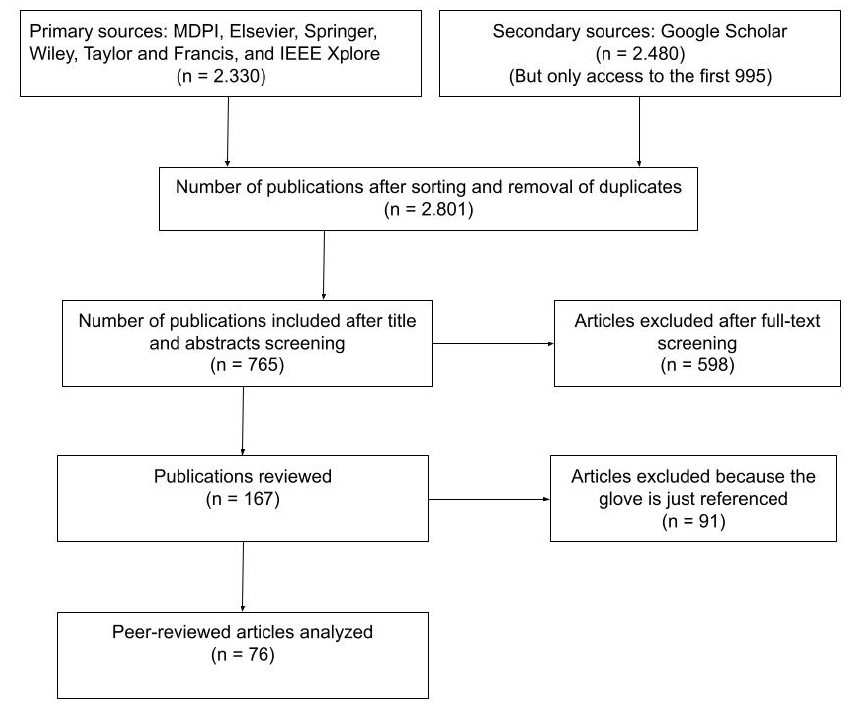
Figure 6. Main results of the PRISMA literature review stages.